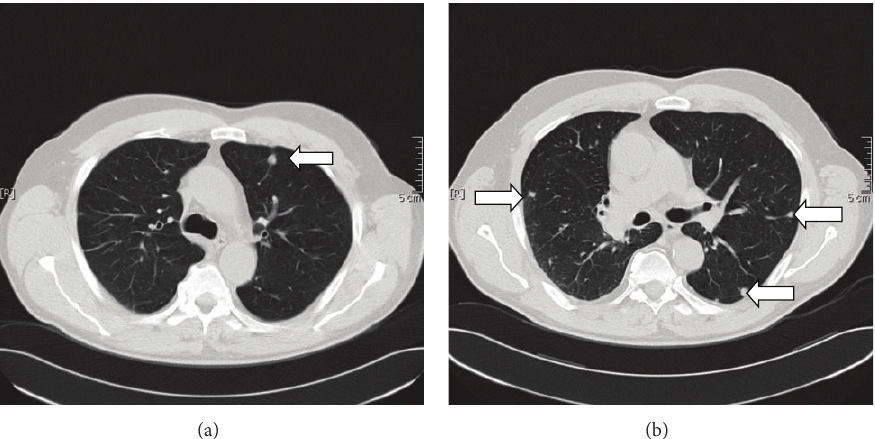
Figure 1: The solitary pulmonary metastasis was resected. (b) Eight months after the wedge resection, we found multiple bilateral pulmonary